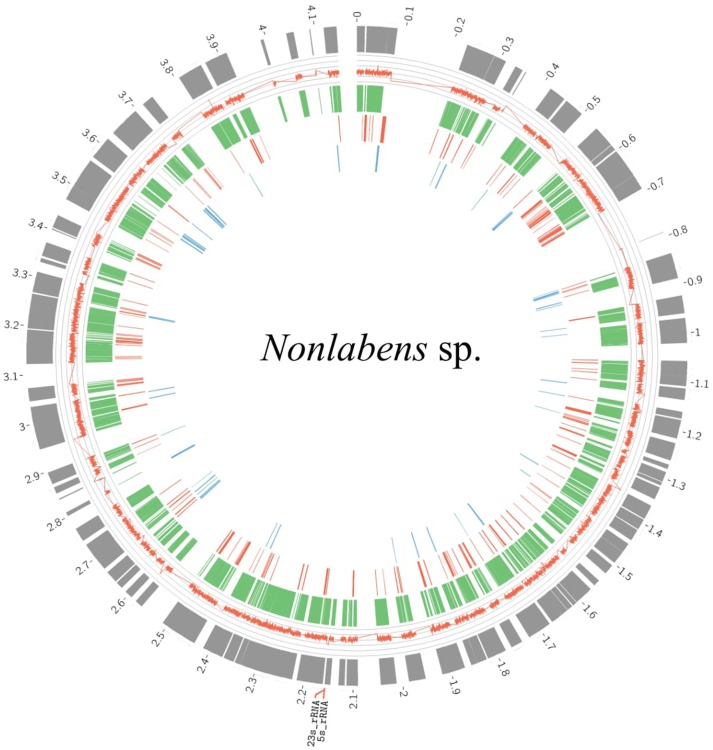
Draft genome organization of Nonlabens sp. sh3vir. and gene conservation among phylogenetically related flavobacterial reference genomes. The outermost concentric circle represents the assembled genome of Nonlabens sp. sh3vir. The green concentric circle depicts Nonlabens dokdonensis DSW-6, with the red and blue ones denoting the Flavobacteria bacterium BBFL7 and Psychroflexus torquis ATCC 700755, respectively. The completeness of draft genome of Nonlabens sp. sh3vir is about 99.8% and the size is ~ 4.2 Mb, comprising 113 contigs. The 5S and 23S rRNA are located between 2.1 and 2.2 Kb.